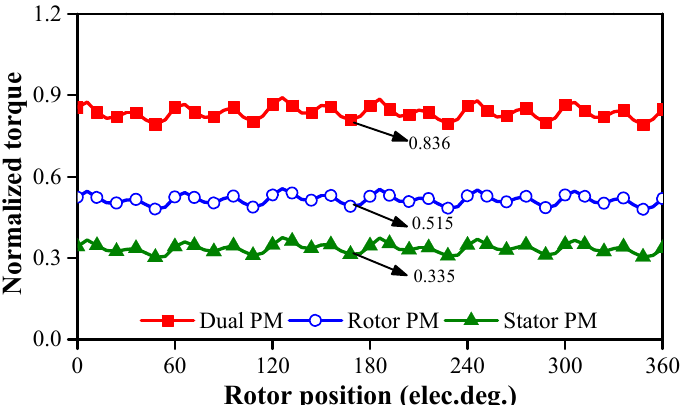
Table 2. Parameters of optimized 6-slot STDPM machines with a different split-tooth number and armature pole pair number.